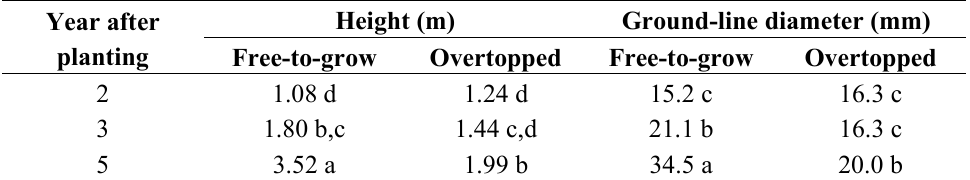
Table 4. Height and ground-line diameter least-squares mean differences between American chestnut trees that were free-to-grow and overtopped for 2, 3, and 5 years after planting. Means followed by the same letter indicate differences were not significant between free-to-grow and overtopped trees within and among years for each growth variable. Height (m) Ground-line diameter (mm) Year after planting Free-to-grow Overtopped Free-to-grow